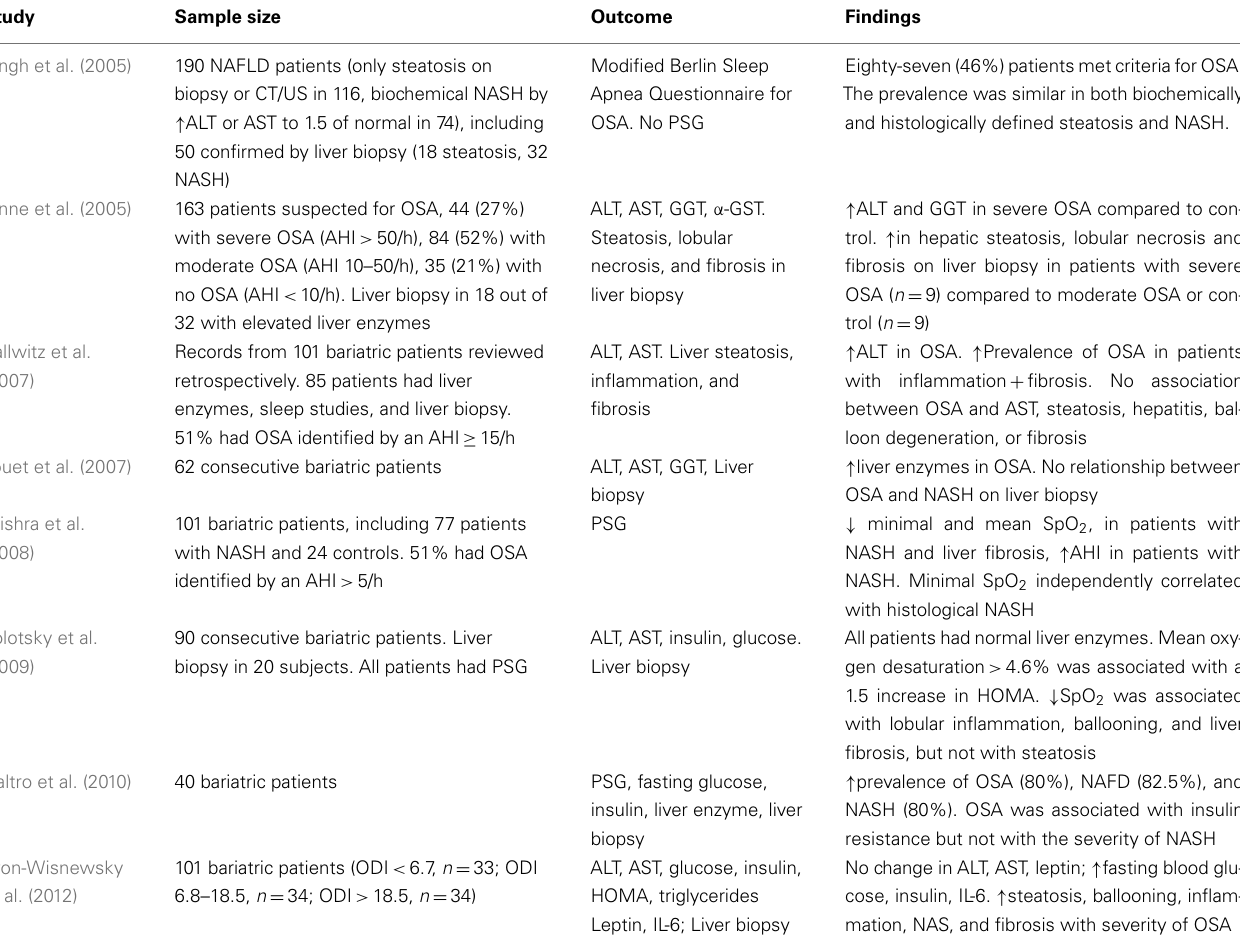
Table 2 | Cross-sectional studies that examined liver biopsies in patients with